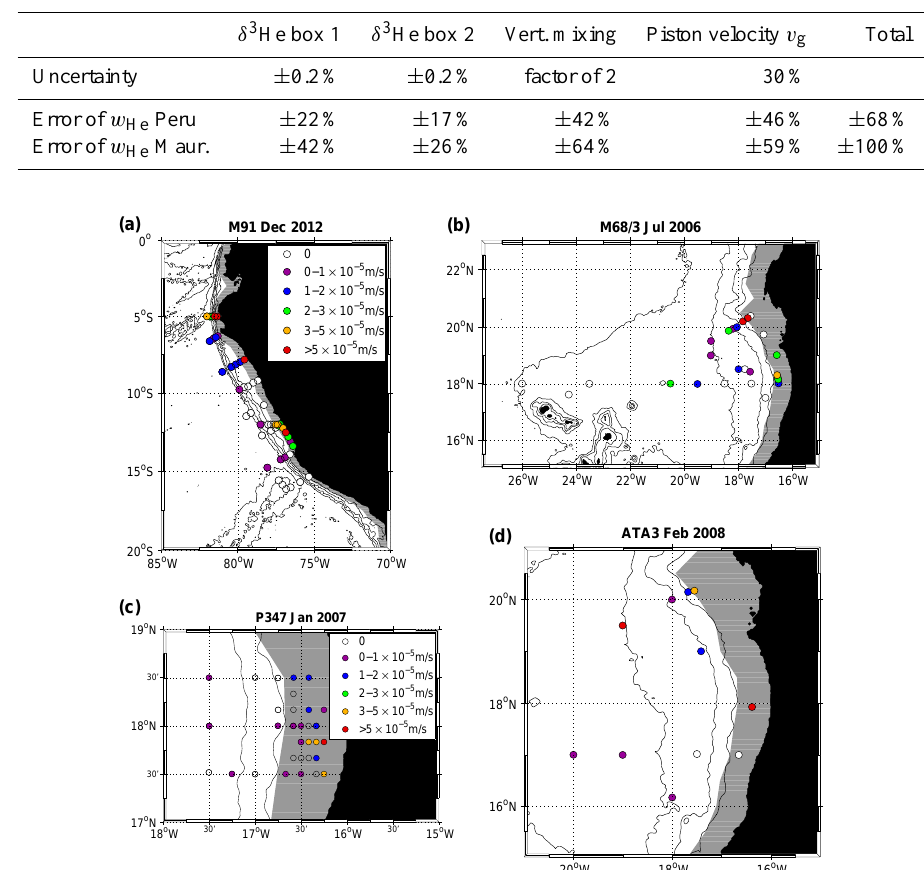
Figure 3. Helium-derived upwelling velocities for cruise M91 off Peru (a) and for cruises M68/3, P347 and ATA3 off Mauritania (b – d) . Isobaths are drawn every 1000m, and the area of the “coastal region” is shaded grey. Note that the uncertainty of the pointwise helium-derived upwelling velocities is 68% for the Peruvian and 100% for the Mauritanian data (for details, see text).